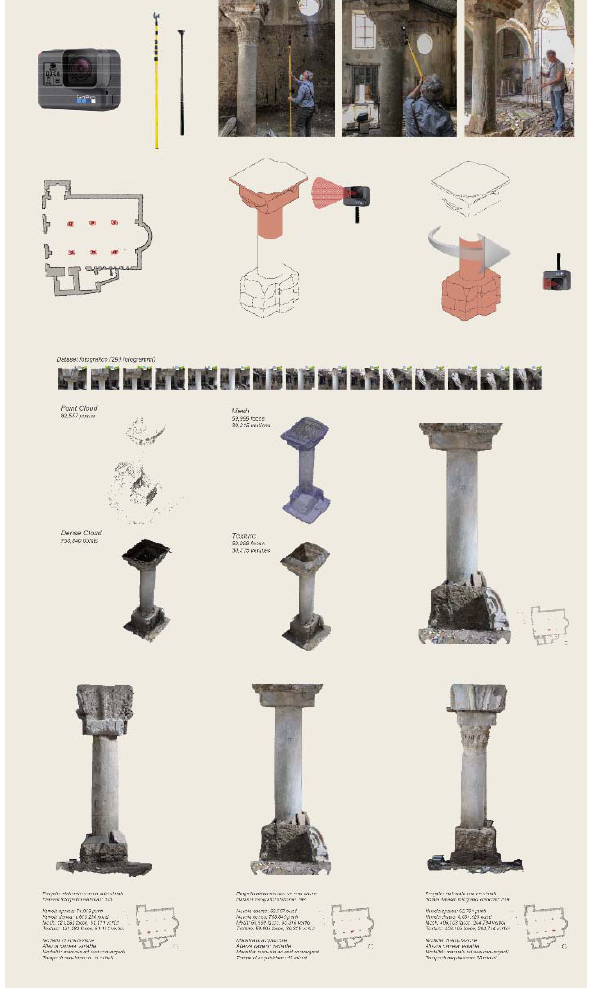
Figure 11. Photogrammetric survey of the columns.